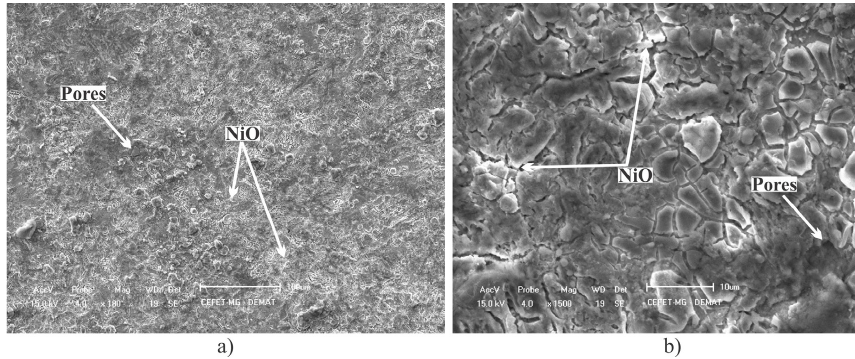
Figure 6. “J5” sample coated with Ni/NiO. 180X (a) and 1500X (b).